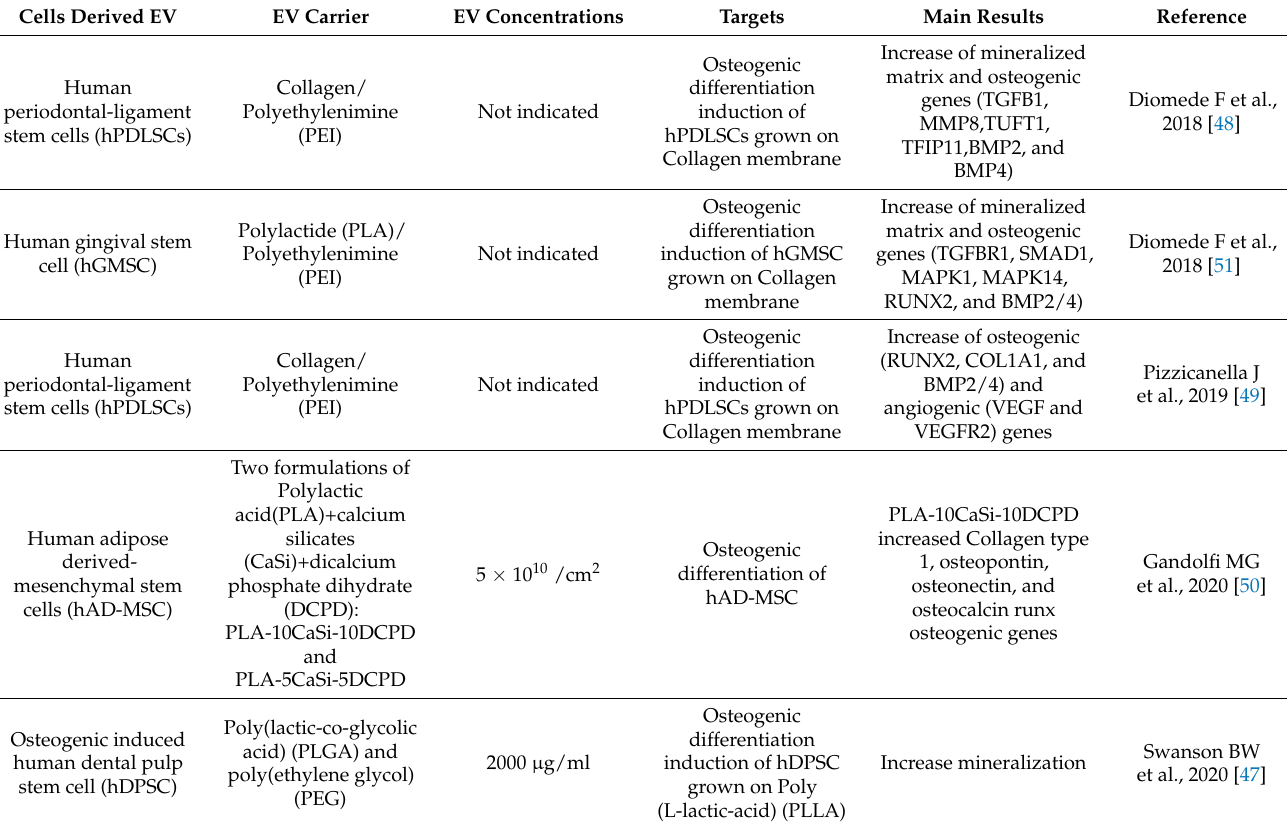
Table 1. EVs combined with scaffolds used to promote bone regeneration: studies in vitro. Targets Main Results